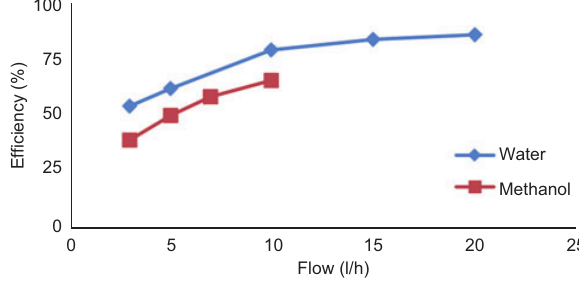
Figure 5 Effi ciency of energy transfer of microwave radiation into heat in the continuous microwave unit (Figure